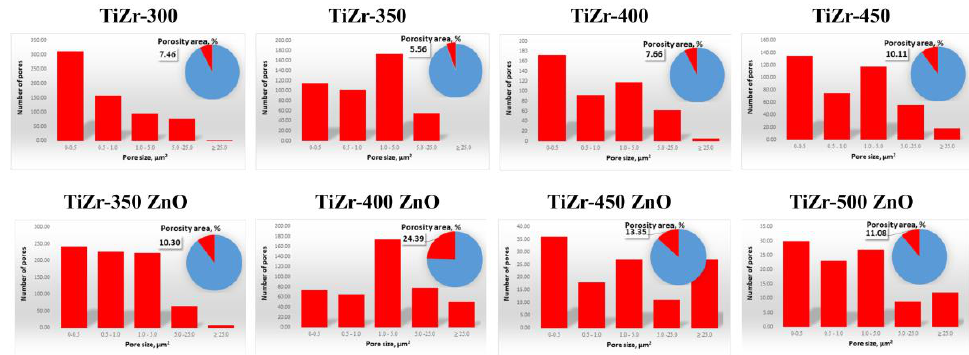
Figure 3. The pore size distribution of PEO-treated implants in Ca(H 2 PO 2 ) 2 electrolyte bath ( upper row ) and with ZnO NPs ( low row ).